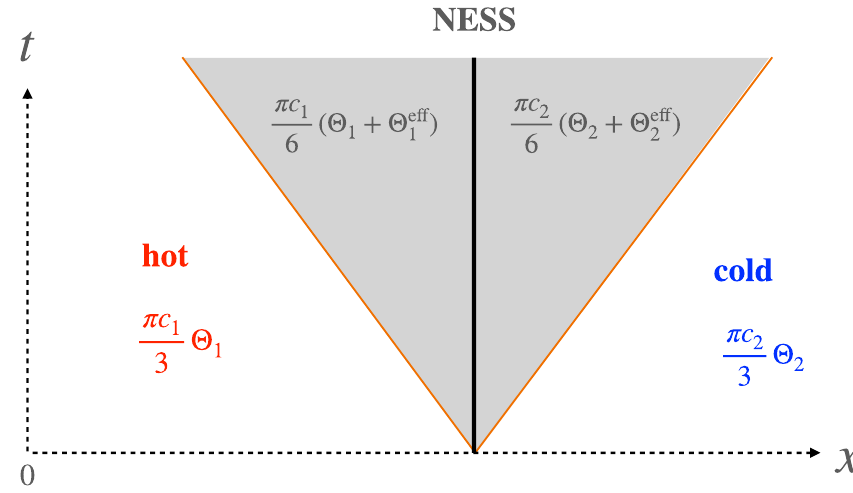
Figure 3 . The entropy densities in the four regions of the partitioning protocol discussed in the text (space is here unfolded). The entropies of the outgoing fluids, which depend a priori on details of the scatterer, have been parametrized by two effective